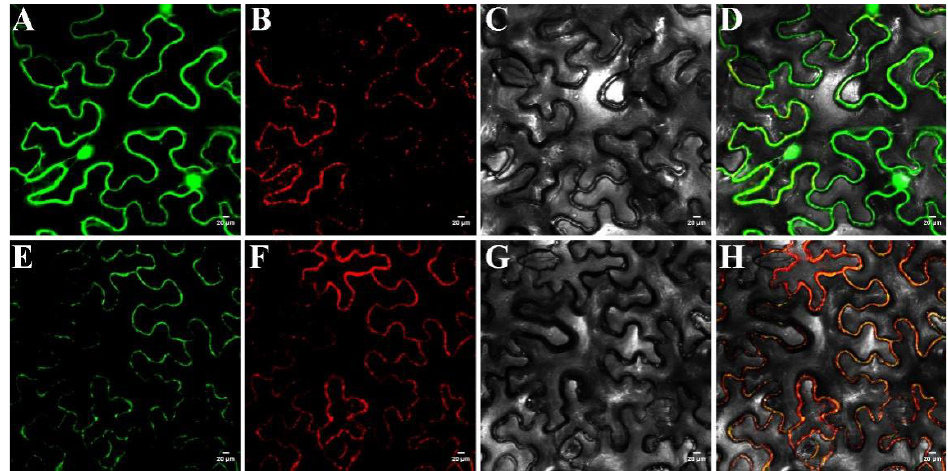
Figure 7. Subcellular localization of Glyma.09G171200 in the mitochondria. ( A ) and ( E ) 35S: GFP and 35S: Rf3-GFP. ( B ) and ( F ) 35S: MSTP-mKate. ( C ) and ( G ) Bright field. ( D ) and ( H ) Merge of dark and bright field. Green shows the signal from GFP, red shows the signal from mKate. GFP, Rf3-GFP, and MSTP-mKate fusions under the control of the CaMV35S promoter were transiently expressed in tobacco protoplasts. Bar= 20 µm.